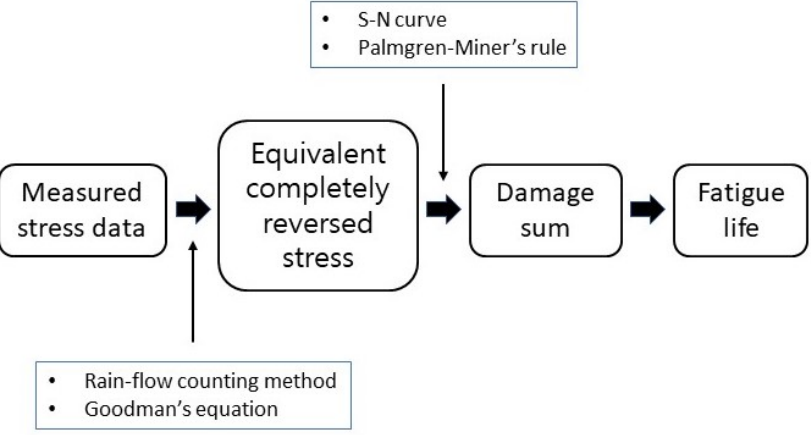
Figure 10. Fatigue life calculation procedure.